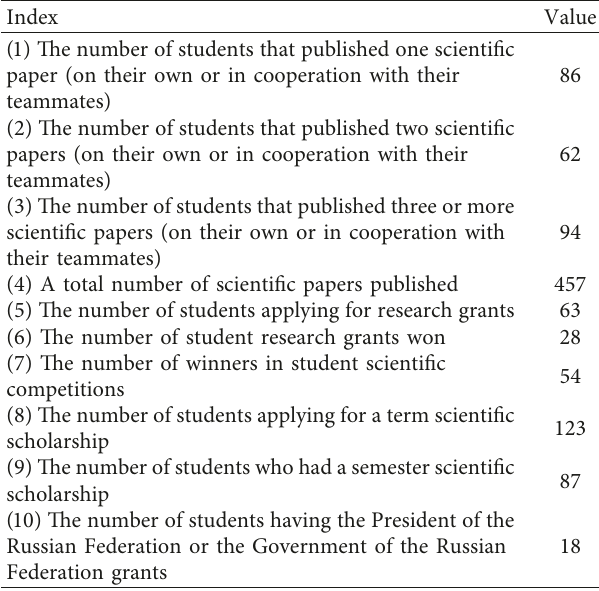
Table 2: Quantitative response of students that have completed The Basic Scientific Research course.